Question: Which visualization type does this figure use?
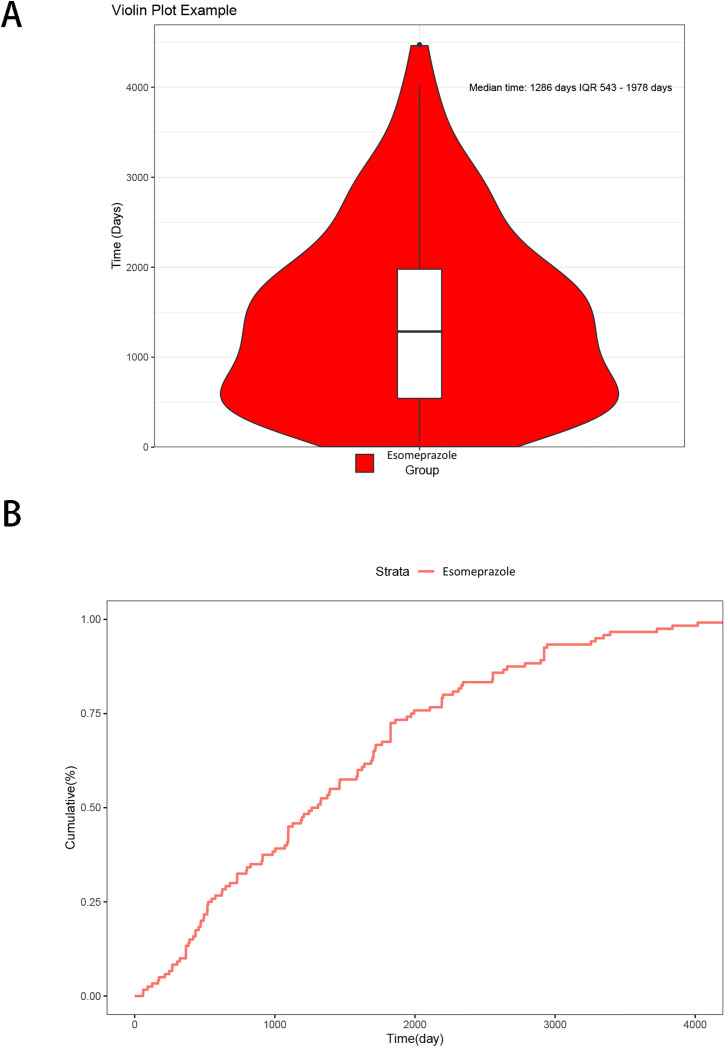
Answer: box